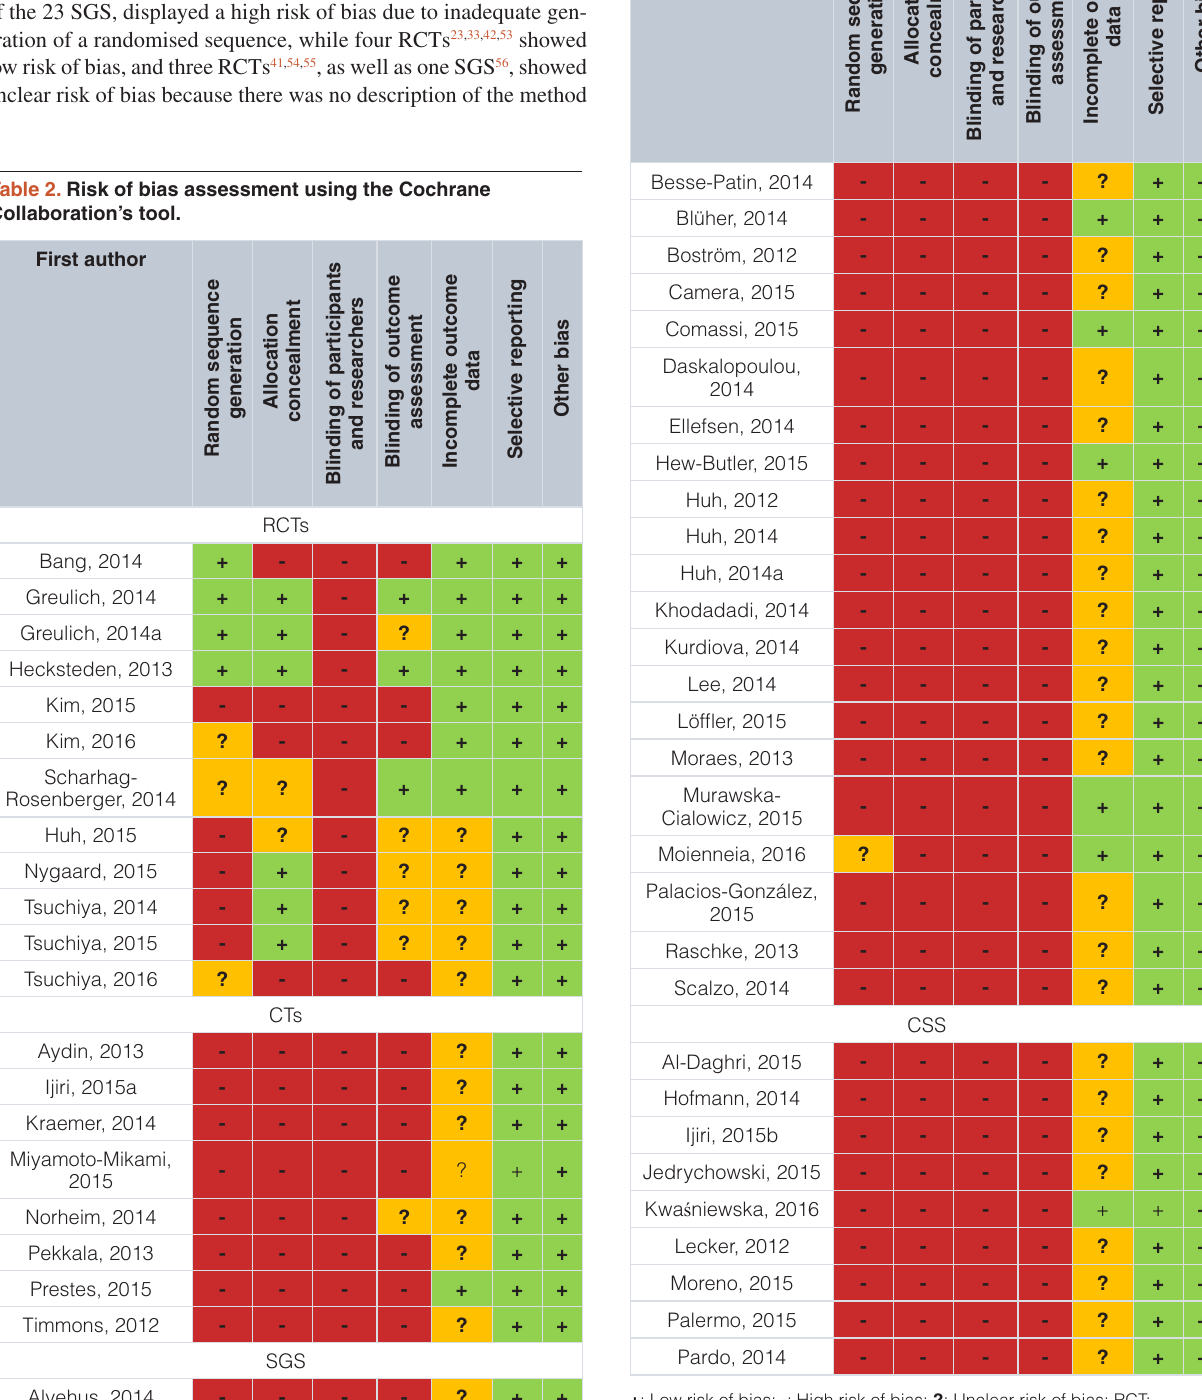
+ : Low risk of bias; - : High risk of bias; ? : Unclear risk of bias; RCT: Randomised controlled trials; CT: Controlled trials; SGS: Single group design studies; CSS: Cross sectional